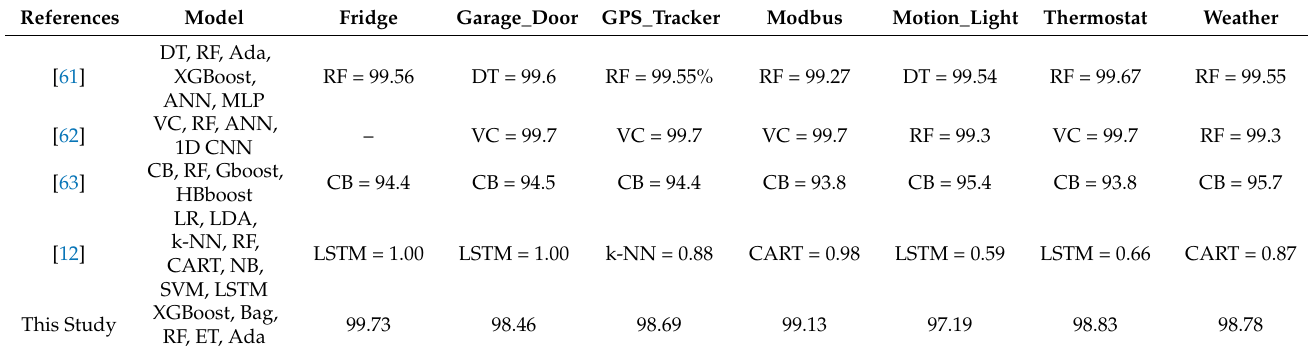
Table 13. Accuracy comparison of existing results based on ToN-IoT